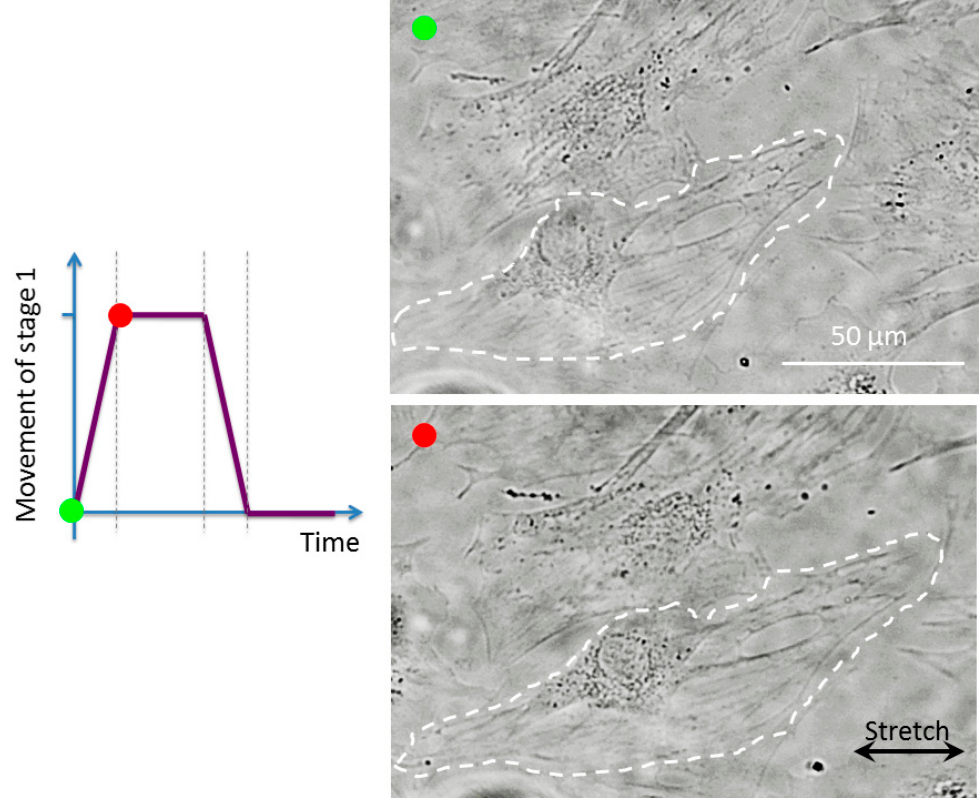
Figure 13. Images of cells exposed to cyclic stretch captured from an on-line movie.